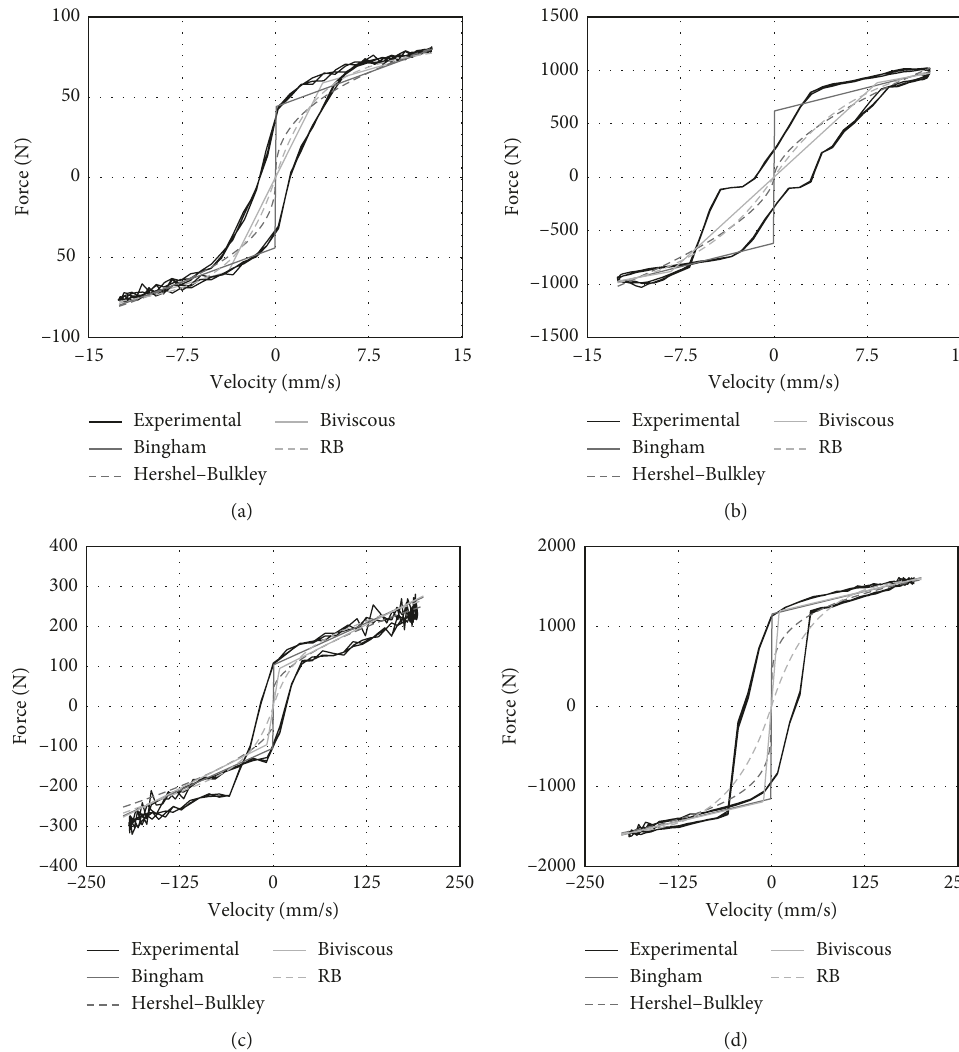
Figure 5: Nonhysteretic model predictions for four different experimental tests: (a) low velocity without intensity; (b) low velocity with I 1 A; (c) high velocity without intensity; (d) high velocity with I (cid:31)